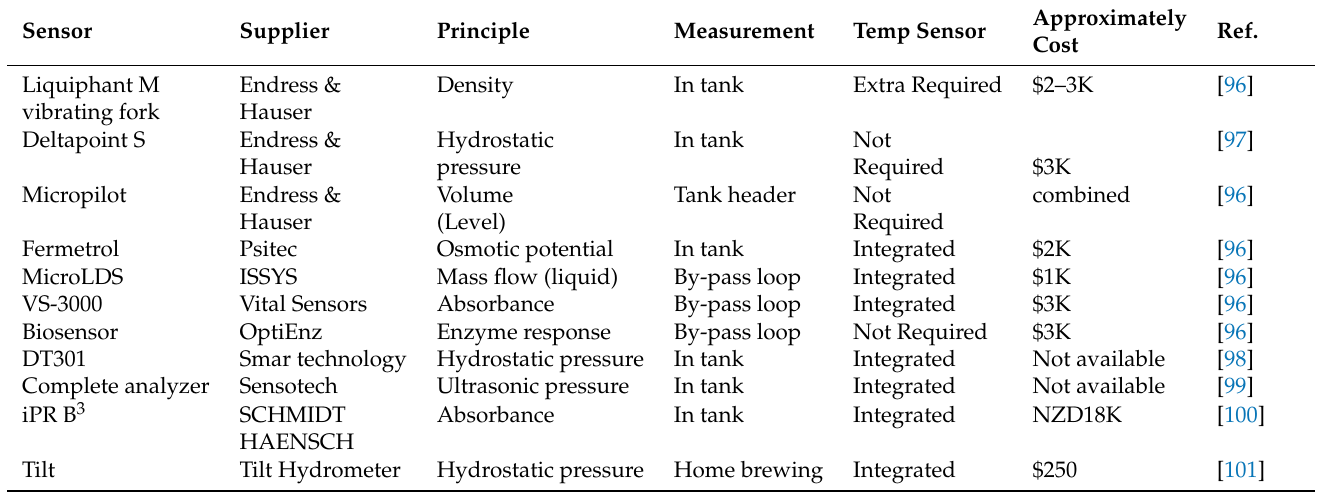
Table 8. Summary of commercially available in-line Brix